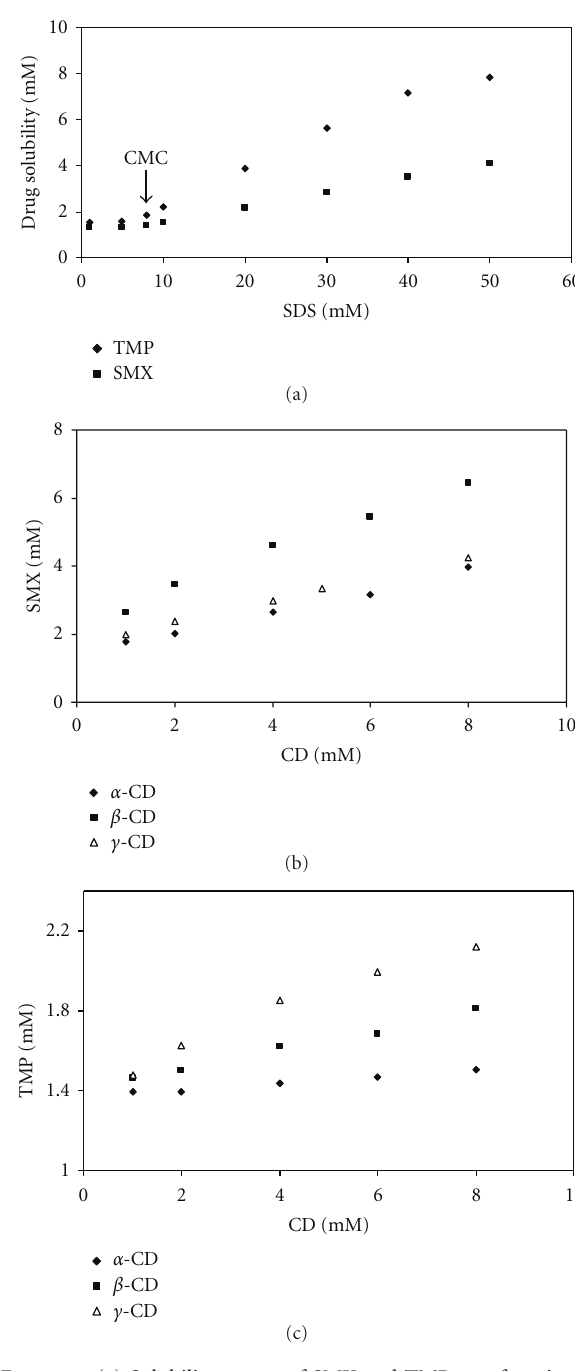
Figure 7: (a) Solubility curves of SMX and TMP as a function of SDS concentration at 298K. (b) Phase solubility diagrams of SMX- CD systems at 298K. (c) Phase solubility diagrams of TMP-CD systems at 298